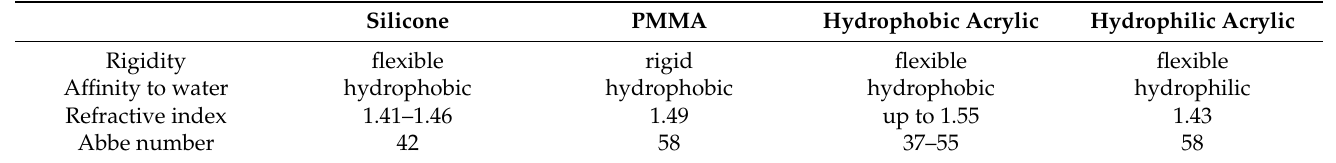
Table 1. IOL-based materials and some of their